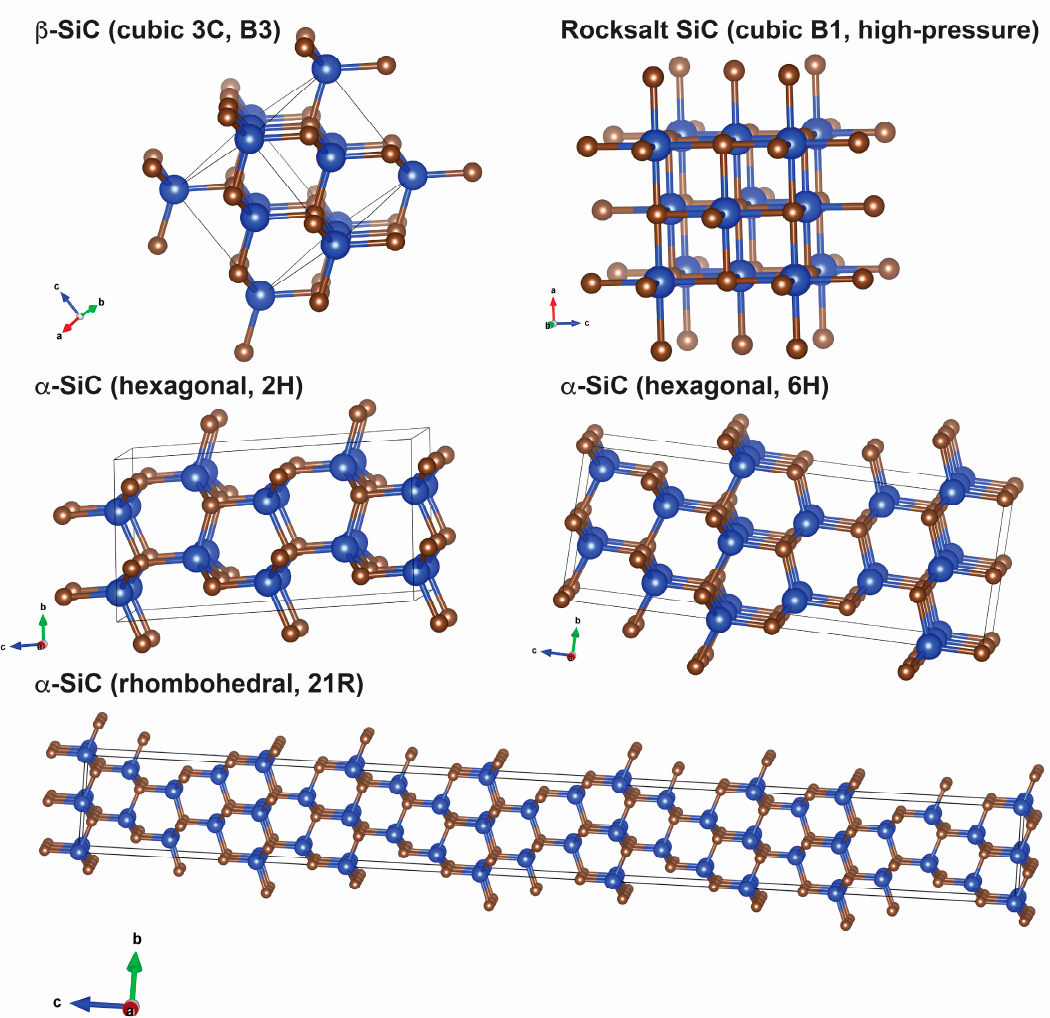
Figure 1. Structure diagram of several low pressure polytypes of SiC as well as the high-pressure rocksalt structure. The larger blue spheres represent the Si atoms while the smaller brown spheres represent the C atoms. Structures visualized using the program VESTA [2] with 3C from [3], 2H from [4], 6H from [5], and 21R from